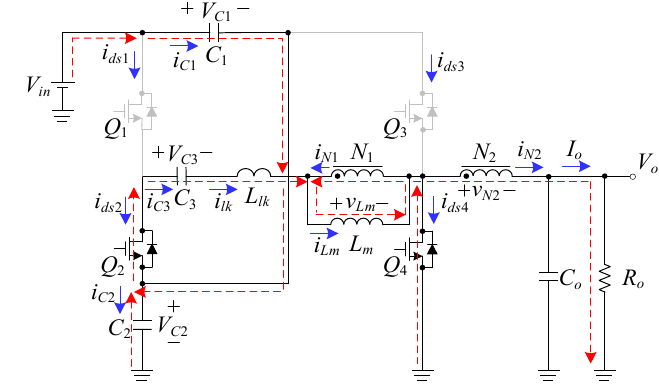
Figure 7. Current flow during state 4.